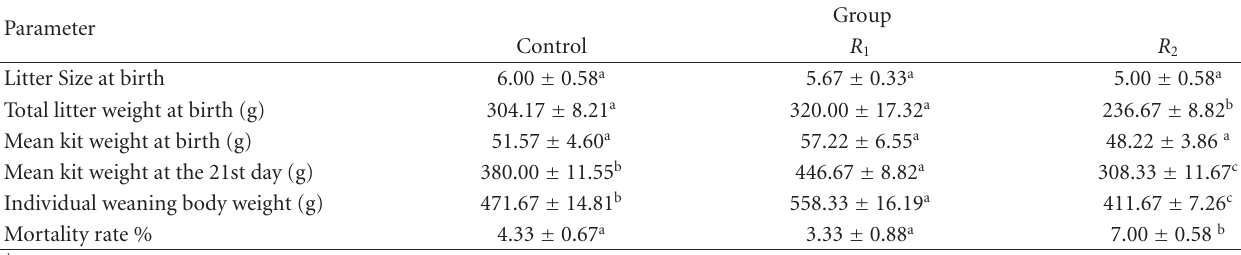
Table 2: The e ff ect of the stage of feed restriction during pregnancy on litter performance (means ± SE).